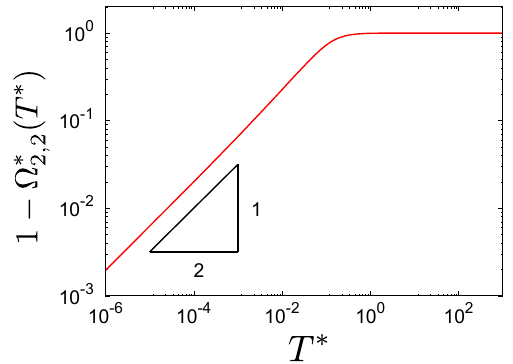
Figure 1. Temperature dependence of the dimensionless Omega integral Ω ∗ ( T ∗ ), where we have introduced T ∗ ≡ k B T / ( k σ 2 ) and 2 , 2 Ω ∗ ( T ∗ ) ≡ Ω 2 , 2 ( T ) / Ω HC ( T ). The triangle represents the slope of 2 , 2 2 , 2 1 − Ω ∗ ( T ∗ ) in the low temperature regime. 2 , 2